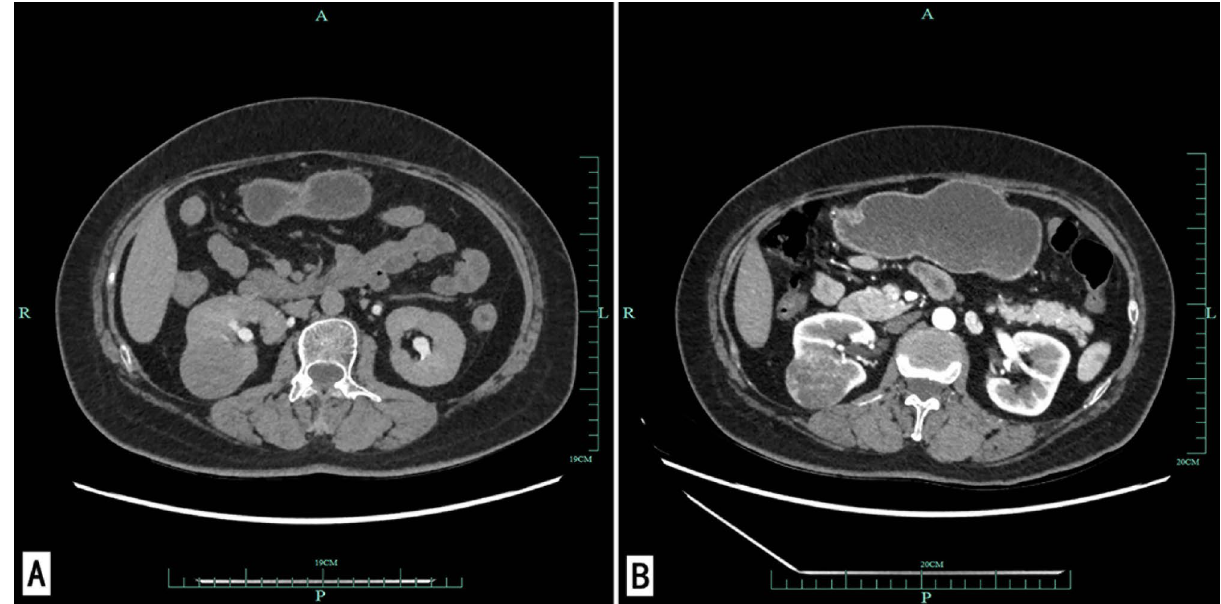
Fig. 1 CT image of urinary system: A, the plain scan image showed a round soft tissue density shadow in the right kidney B, the enhanced image showed uneven and obvious enhancement in the cortical phase, and the degree of enhancement was slightly lower than that of the renal